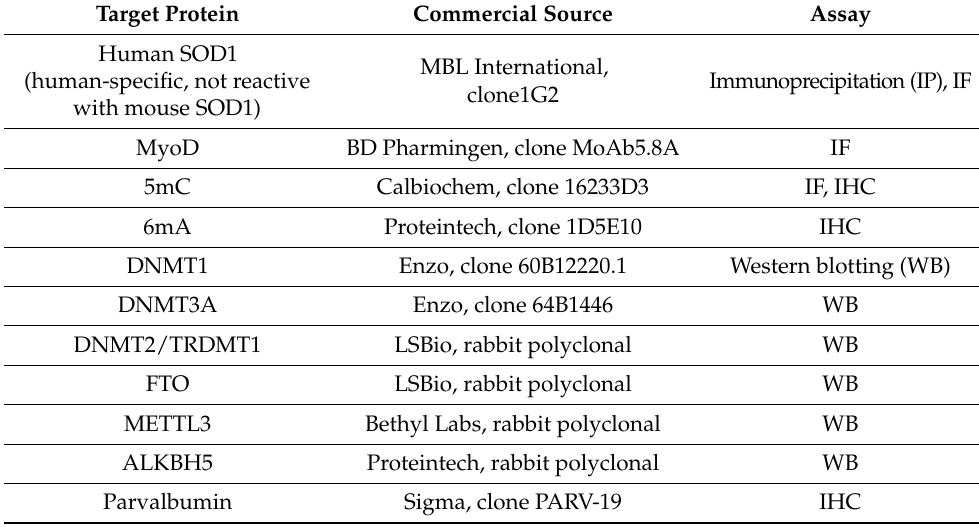
Table 1. Primary Antibodies